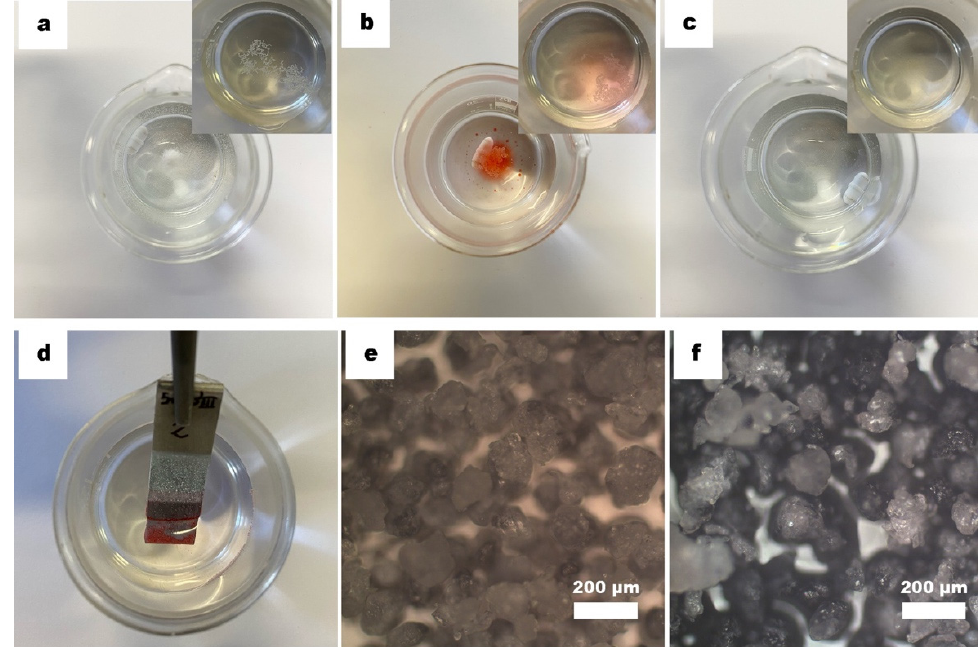
Figure 7. Three different steps to completely remove the MPs from water, with the insets showing the HDPE-MP powder: ( a ) aqueous solution containing 30 mg of HDPE-MP; ( b ) after stirring, the MPs migrated to the organic phase (in red, Oil Red O); ( c ) the solution without any MP or hexane; ( d ) the superhydrophobic coating removing the organic phase containing the HDPE-MP powder; ( e ) HDPE-MPs before the removal process; and ( f ) after the process, with no changes in their morphology and size.